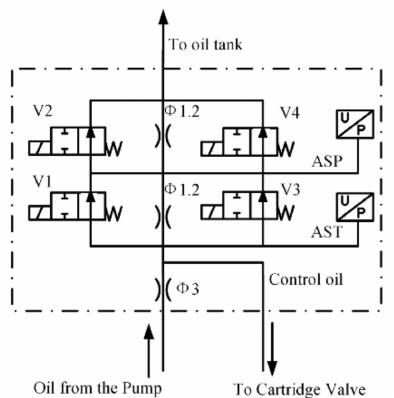
Figure 1. Schematic diagram of two-stage pressure control.